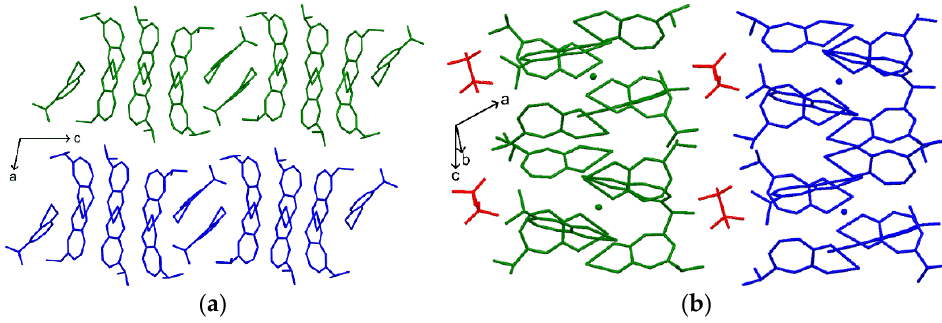
Figure 10. The arrangement of molecules in the extended structures of ( a ) 3 and ( b ) 4 . The shortest Tl···Tl distances between neighboring Tl(hino) molecules in 3 were equal to 3.904(1) Å (Tl1···Tl4), 3.905(1) (Tl2···Tl3), and 4.001(1) Å (Tl3···Tl4), close to double the van der Waals radius of thallium (3.92 Å [37]), and they could be considered as a weak